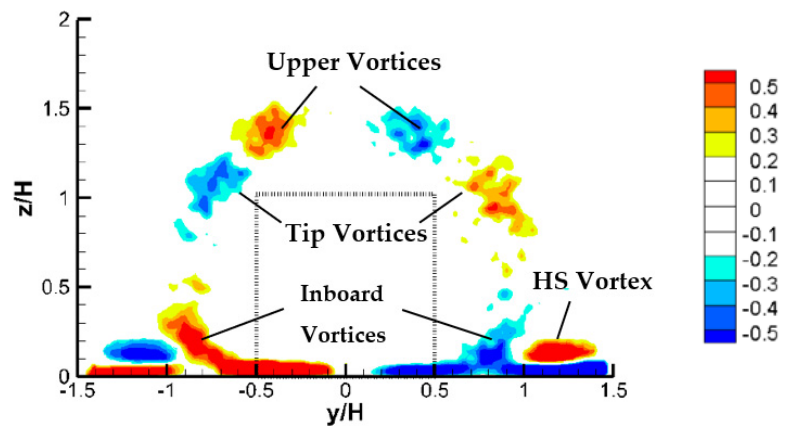
Figure 9. Naming convention of the main vortex structures identified in the cube wake.